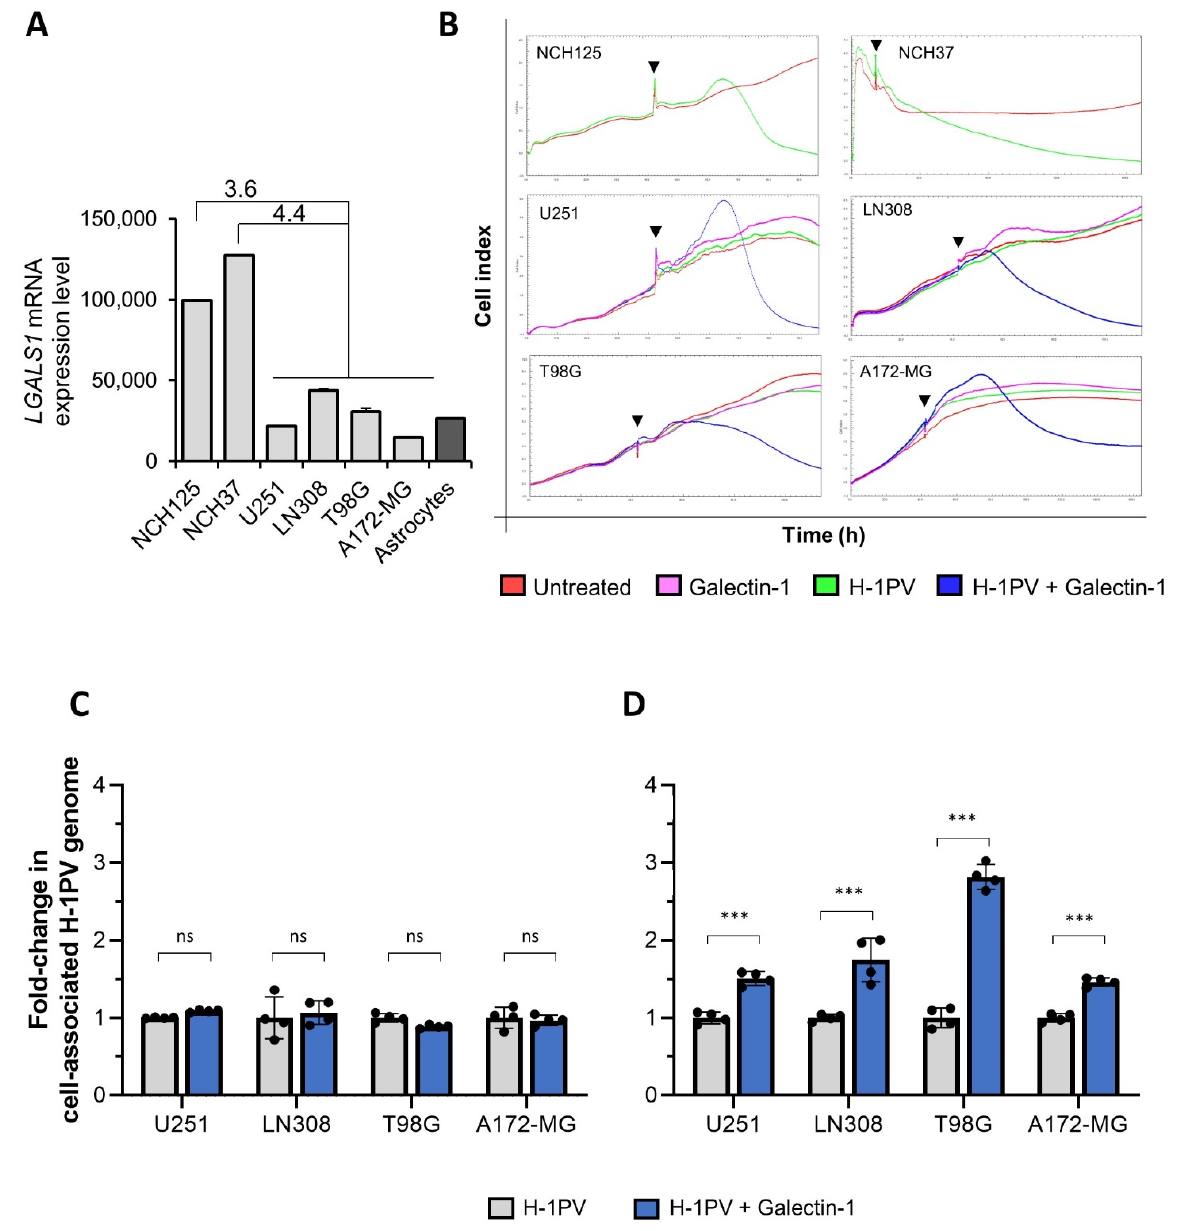
Figure 9. Galectin-1 levels in glioma cell lines determine the success of H-1PV infection. ( A ) Total mRNA was isolated from glioma cell lines susceptible (NCH125; NCH37) or semi-permissive (U251; LN308; T98G; A172-MG) to H-1PV infection, and LGALS1 mRNA transcripts were measured using nCounter analysis. Bar graph depicts the LGALS1 transcript counts; numbers on the top of the col- umns indicate gene expression fold changes between susceptible and semi-permissive cancer cell lines. The independent experiment is shown; n = 1 (NCH125, NCH37, U251 and A172-MG); n = 2 (LN308 and T98G); n = 3 (human astrocytes) biologically independent samples. ( B ) NCH125 and NCH37 cell lines were either infected with H-1PV at an MOI of 5 pfu/cell (green) or left untreated (red). Semi-permissive cell lines were infected with H-1PV at an MOI of 5 pfu/cell (green), incubated with 5 μ g/mL of human recombinant Gal-1 (pink), H-1PV and Gal-1 simultaneously (blue), or left untreated (red). Cell viability was assessed by xCELLigence every 30 min in real time. The curve shows the “Cell index” mean of three biologically independent samples ( n = 3) at any given time, which is proportional to the viability of the cell population. Black arrows indicate the time of treat- ment. ( C ) H-1PV binding at the cell surface is not affected by Gal-1 addition. U251, LN308, T98G and A172-MG cells were incubated with H-1PV alone at an MOI of 5 pfu/cell or with H-1PV and